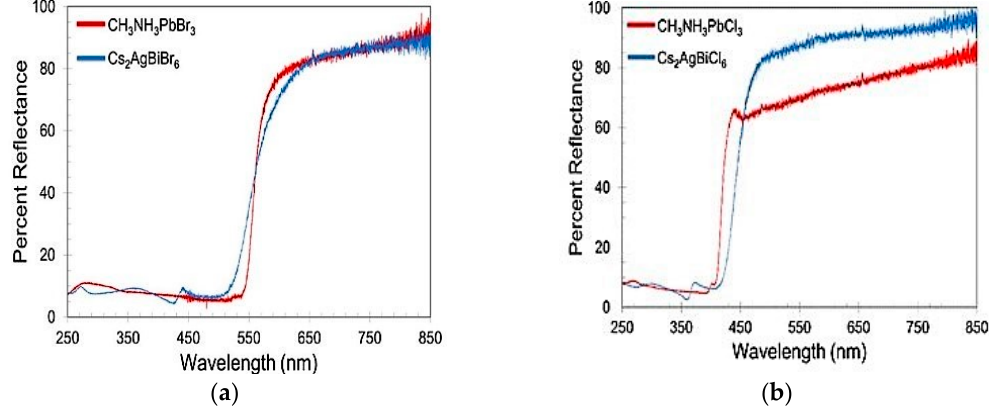
Figure 5. ( a ) UV-Vis diffuse reflectance spectra for Cs 2 AgBiBr 6 and MAPbBr 3 , ( b ) UV-Vis diffuse reflectance spectra for Cs 2 AgBiCl 6 and MAPbBr 3. Reproduced with permission from Reference [36]. American Chemical Society, 2016.